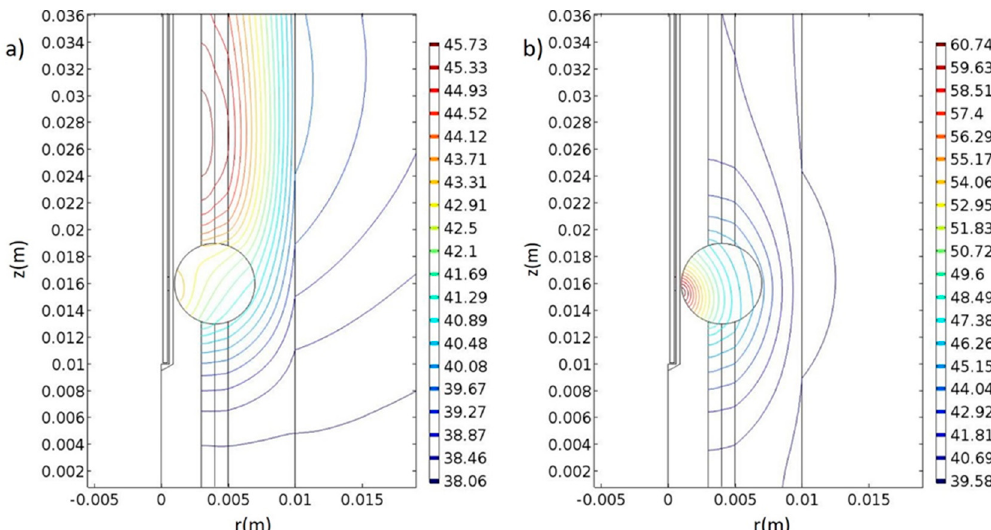
Figure 13. Simulation of microwave-induced temperature effects for melanoma tissue. ( a ) Temperature distribution at the 9th minute of treatment where the antenna is tuned at 2.4 GHz with power of 10 W. ( b ) Temperature distribution at the 30th minute of heating and the antenna is tuned at 433 MHz with 100 W power. The unit of the contours in Celsius degrees, and the unit of x- and y-axes in meters.